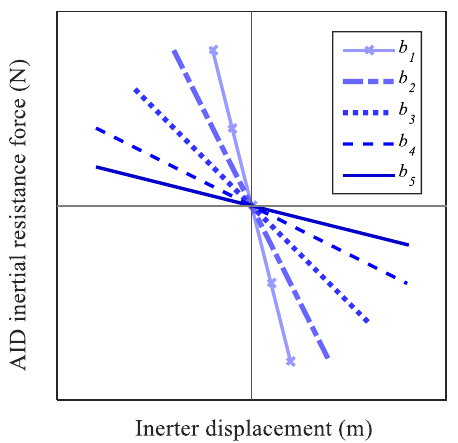
Figure 4. Force-displacement correlation curve of the proposed AID.